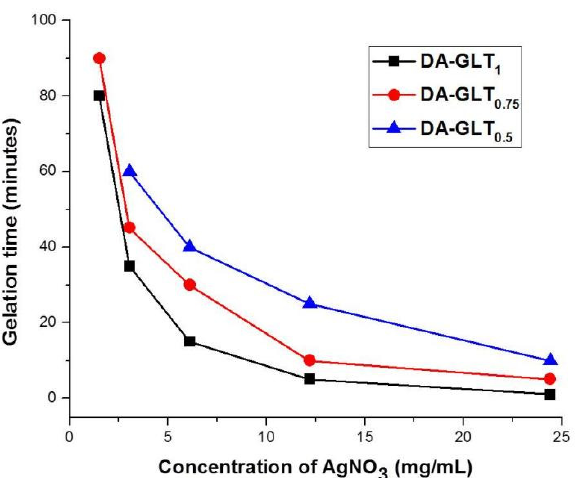
Figure 1. Relationships between gelation time and the feeding concentrations of AgNO 3 at different DA conjugation densities. Table 1. Gelation time of different DA-GLT at different contents of DA-GLT (the weight ratio of DA-GLT to AgNO 3 in feed is fixed at 50:11).